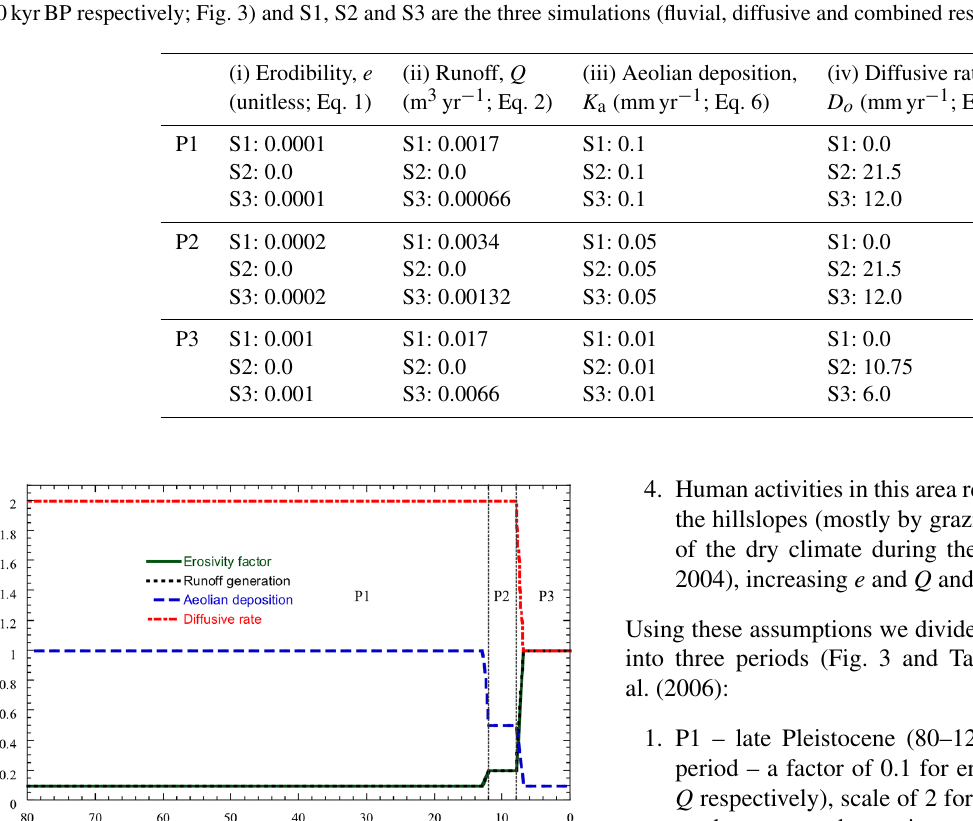
Table 1. Values of the parameters that are driven by the simulation scenario. P1, P2 and P3 are the three simulated periods (80–12, 12–8 and 8–0kyrBP respectively; Fig. 3) and S1, S2 and S3 are the three simulations (fluvial, diffusive and combined respectively).